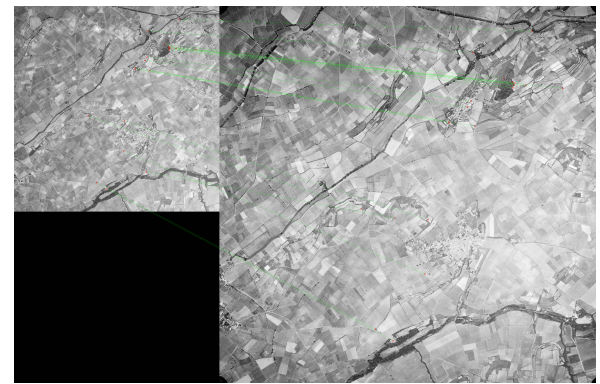
Figure 2. SIFT matching result on an inter-epoch image pair with rotation and scale